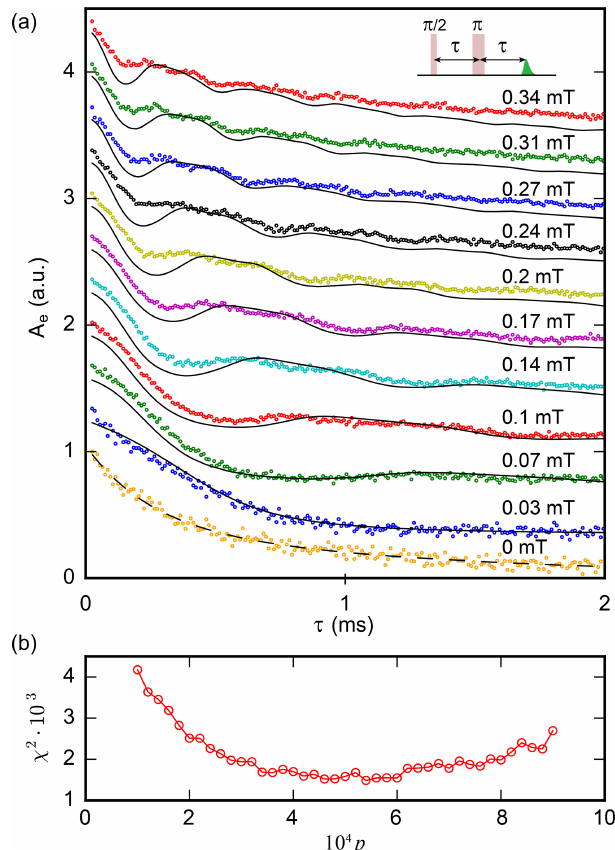
Figure 9. Two-pulse ESEEM of Bi : Si donors. (a) Echo integral A e versus inter-pulse delay τ for a two-pulse echo sequence for varying magnetic field B 0 . Dots indicate experimental data; lines indicate results of the model (see text), assuming a concentration in 29 Si of p = 4 . 4 × 10 − 4 . The curves are vertically shifted for clarity. (b) Fit residue χ 2 for different 29 Si relative abundance p . The best fit is obtained for p = 4 . 4 ± 1 × 10 − 4 , in agreement with the specified